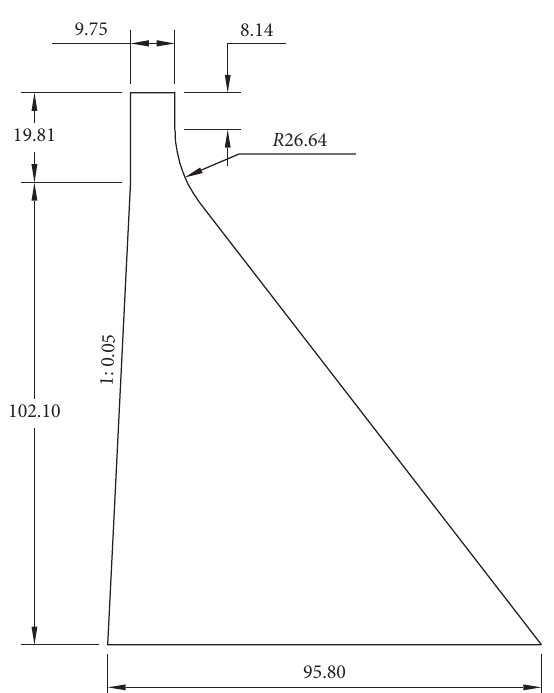
Figure 5: Cross-sectional geometry of monolith 16 of the Pine Flat dam (Unit: m).